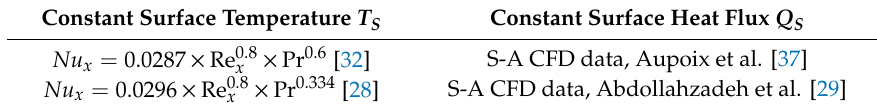
Table 3. Flat plate correlations and data compared with CFD for di ff erent B.C. S-A: